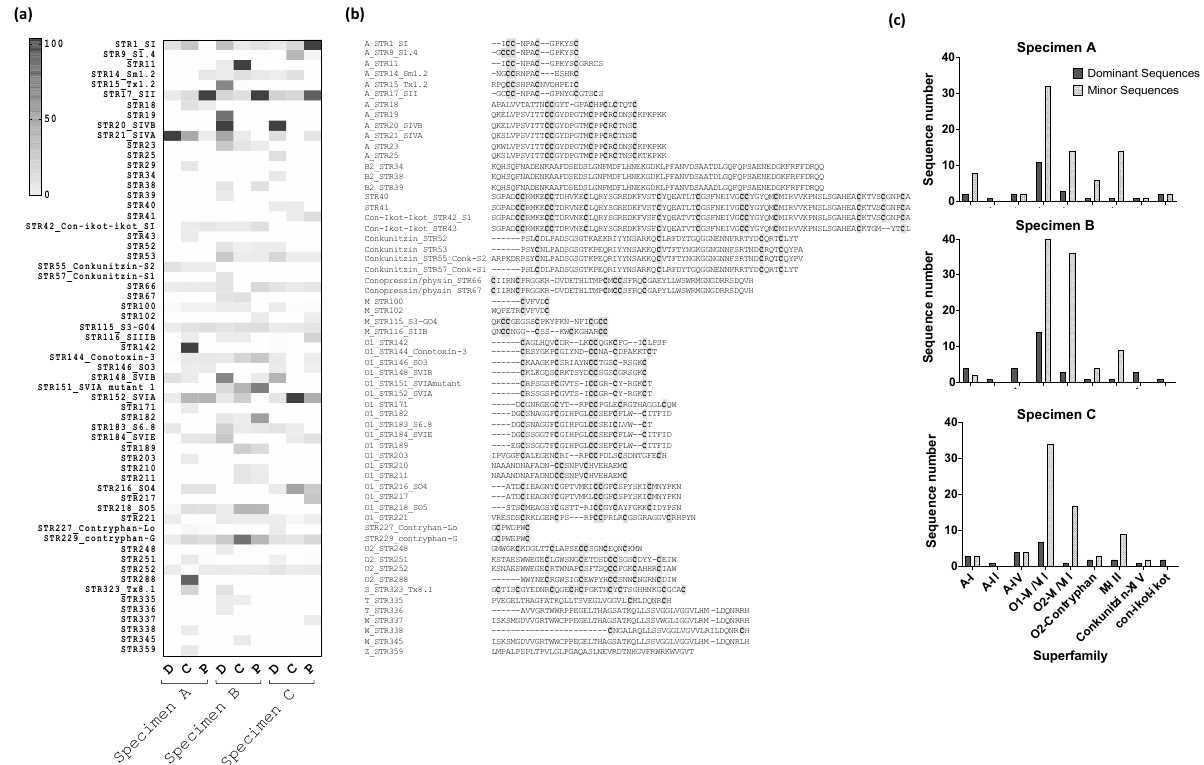
Figure 3. Expression level variation of the major conotoxin (relative expression level > 1%) precursors across the transcriptomes of three venom duct sections (distal, central and proximal) in three adult C. striatus (specimens A–C). (a) Heat map showing the distribution of dominant peptides across the duct section in three specimens. Relative expression levels are indicated as % TPM relative to the maximum TPM in each venom duct segment transcriptome. (b) The mature conotoxin sequence of the dominant sequences found across all nine transcriptomes studied in the same rank order as the heat map. (c) Bar graphs visualizing the contribution of the dominant and minor peptides to each main superfamily in three specimens of C. striatus